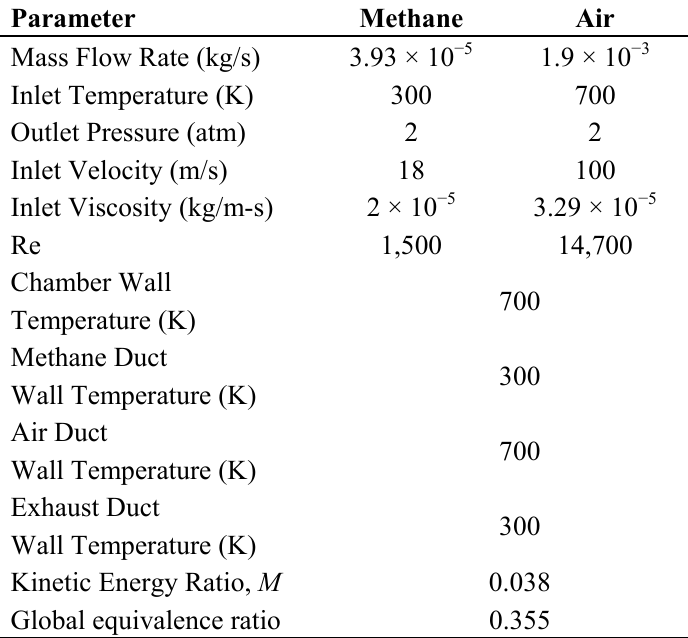
Table 1. Operating